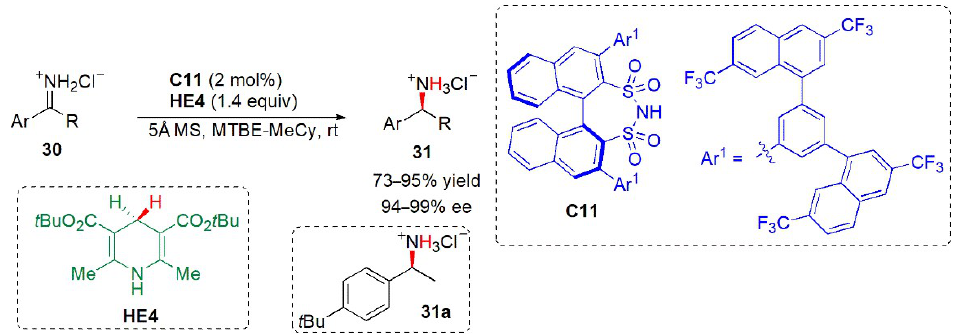
Figure 13. Highly enantioselective disulfonimide-catalyzed ETH of NH–imine hydrochloride salts